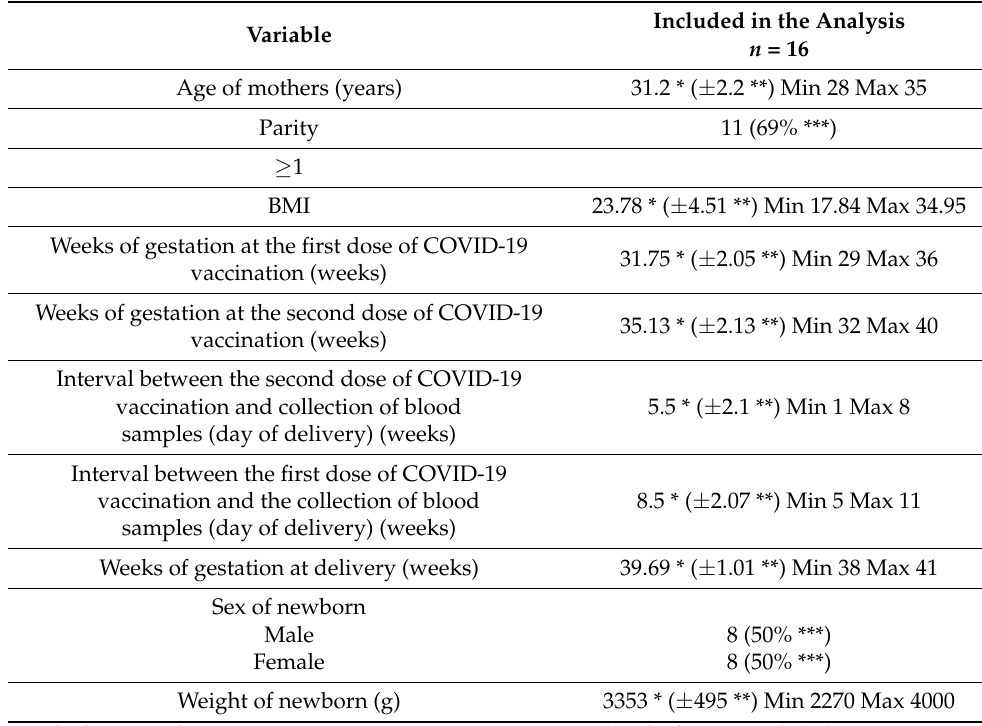
Table 1. Maternal and newborn demographic and clinical